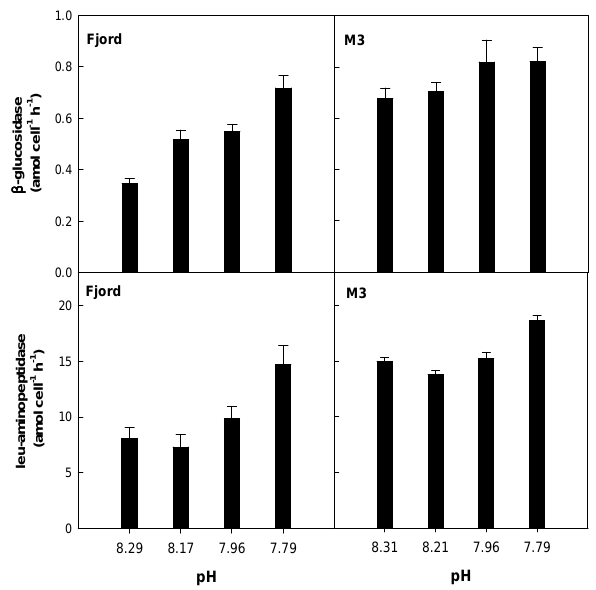
Fig. 12. Activity of extracellular β -glucosidase and leu- aminopeptidase in samples of Kongsfjorden and one control meso- cosm (M3) at in situ pH (fjord: 8.29, M3: 8.31) and after acidifica- tion with dilute hydrochloric acid (pH 7.79–8.17). Rates at pH 7.79 were significantly higher than at in situ pH (Wilcoxon signed rank test, p = 0 .